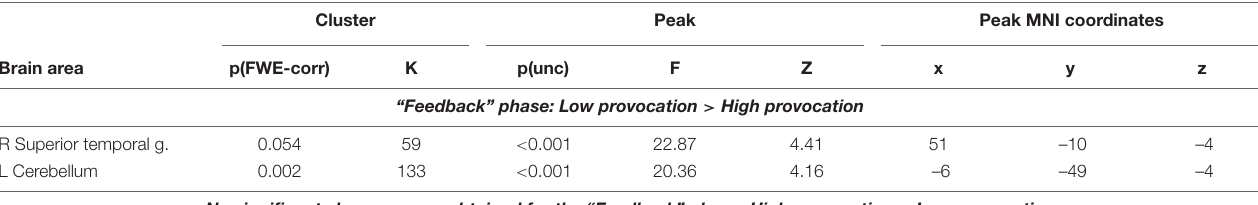
TABLE 6 | Results of the group-level gPPI analysis with the ROI in the right IFG, associated with the observation of different levels of provocation (uncorrected p < 0.001 at the voxel level, FWE-corrected at the cluster level p < 0.05, and k = 15). Cluster Peak Peak MNI coordinates Brain area